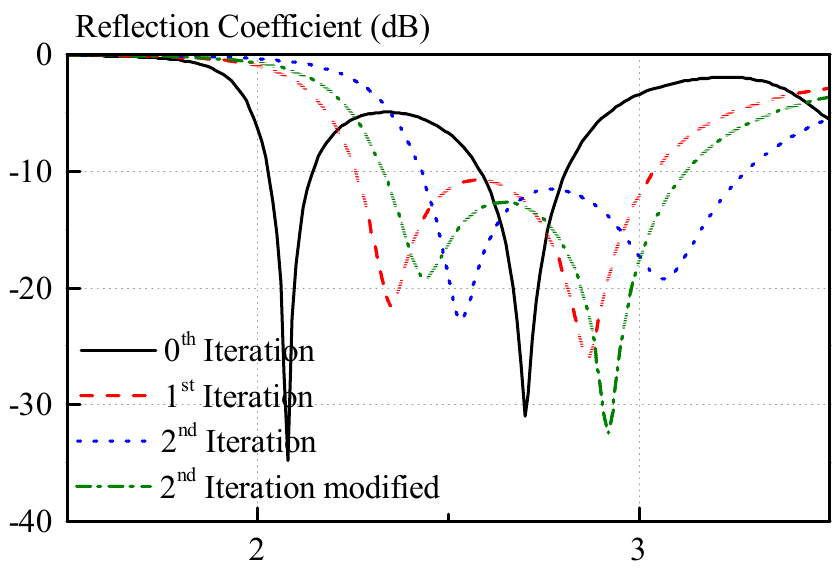
Figure 7. Variation of the reflection coefficient of the menger sponge fractal for different iterations with a = b = h = 25 mm and a dielectric constant of 10.14. The feeding circuit for each iteration is optimized such that maximum bandwidth can be achieved. The feeding parameters for each iteration are: l slot,0 = 20 mm, l stub,0 = 6 mm, l slot,1 = 21 mm, l stub,1 = 6.5 mm, l slot,2 = 21 mm, l stub,2 = 5.5 mm, and l slot,2mod = 21 mm, l stub,2mod = 6.5 mm.